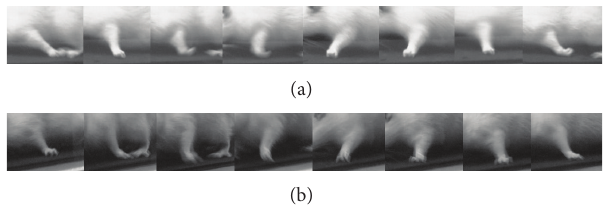
Figure 4: Sequential photographs of left forelimb movement on day 42 after hemisection. (a) Juvenile rat. (b) Adult rat.